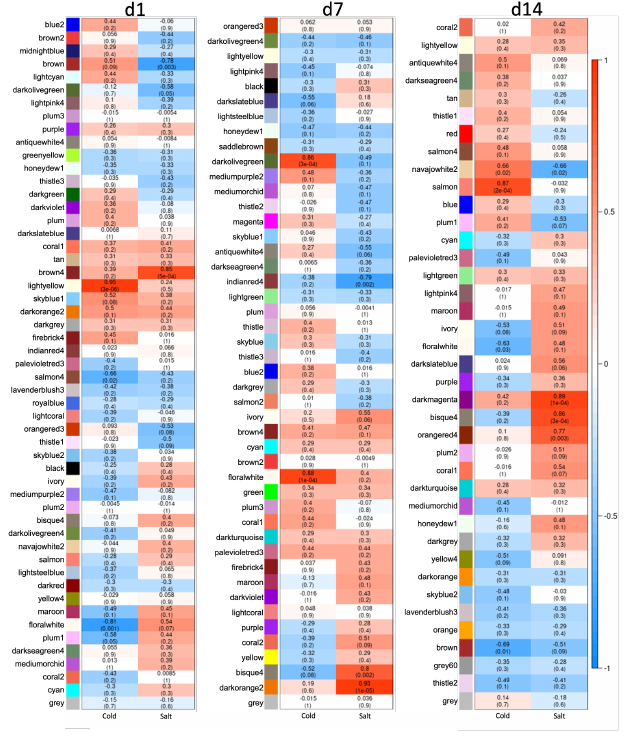
Figure A6. Module-trait correlation for the transcriptome of Mazurka. RNASeq data was used to perform a WGCNA . Shown here is the relationship for each identified cluster with the single stress chilling temperature (Cold), or salt (Salt) as indicated at d1, d7 or d14. On the y-axis, all identified modules are listed with their respective names. Color and number indicate the correlation between module and binary trait for eigengenes and numbers in brackets the p -Value for